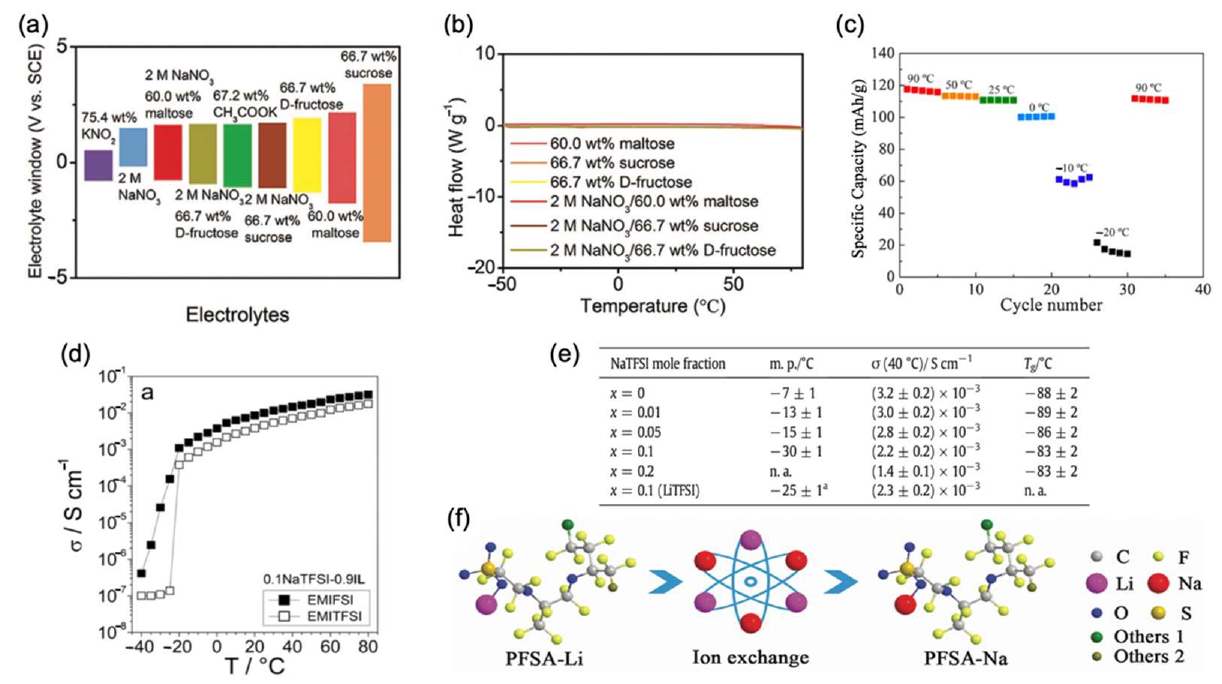
Figure 11. ( a ) Electrochemical windows for different electrolytes. ( b ) Heat flow of six sugar-based electrolytes in a wide temperature range. Reproduced with permission from Ref. [75]. Copyright